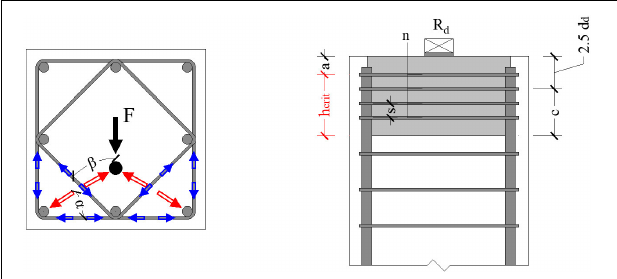
FIGURE 4 | Zoubek et al. model: strut and tie model for a connection with a single dowel (left and center) and schematic representation of the activated stirrups (right). Adapted from Zoubek et al. (2015).